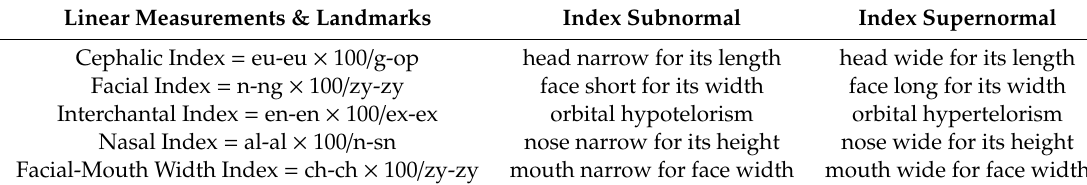
Table 1. Cranio-Facial Indexes.